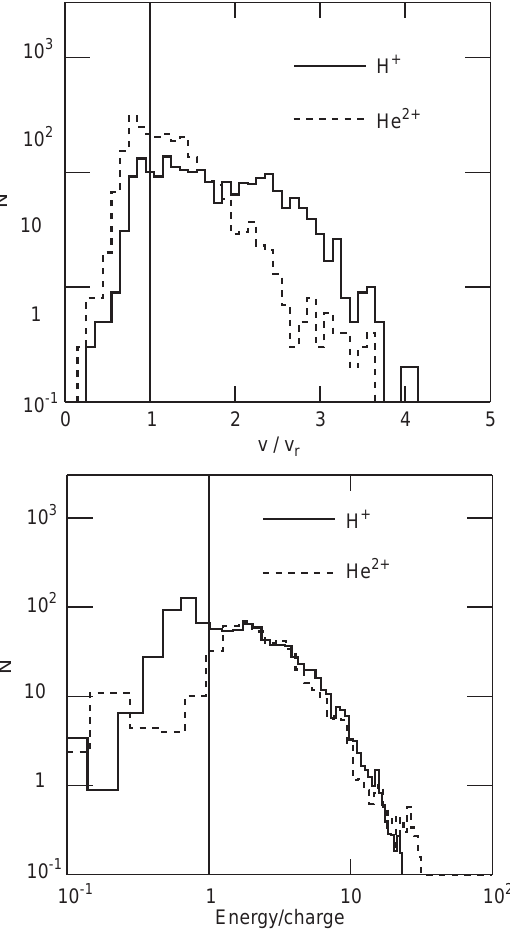
Fig. 12. Histogram of number of ions (protons: solid line ; alpha particles: dashed line ) versus velocity in units of shock velocity ( upper panel ) and versus energy per charge in units of shock ramming energy ( lower panel ), when the ions cross for the first time a boundary located at 10 c = x pi in front of the shock in th